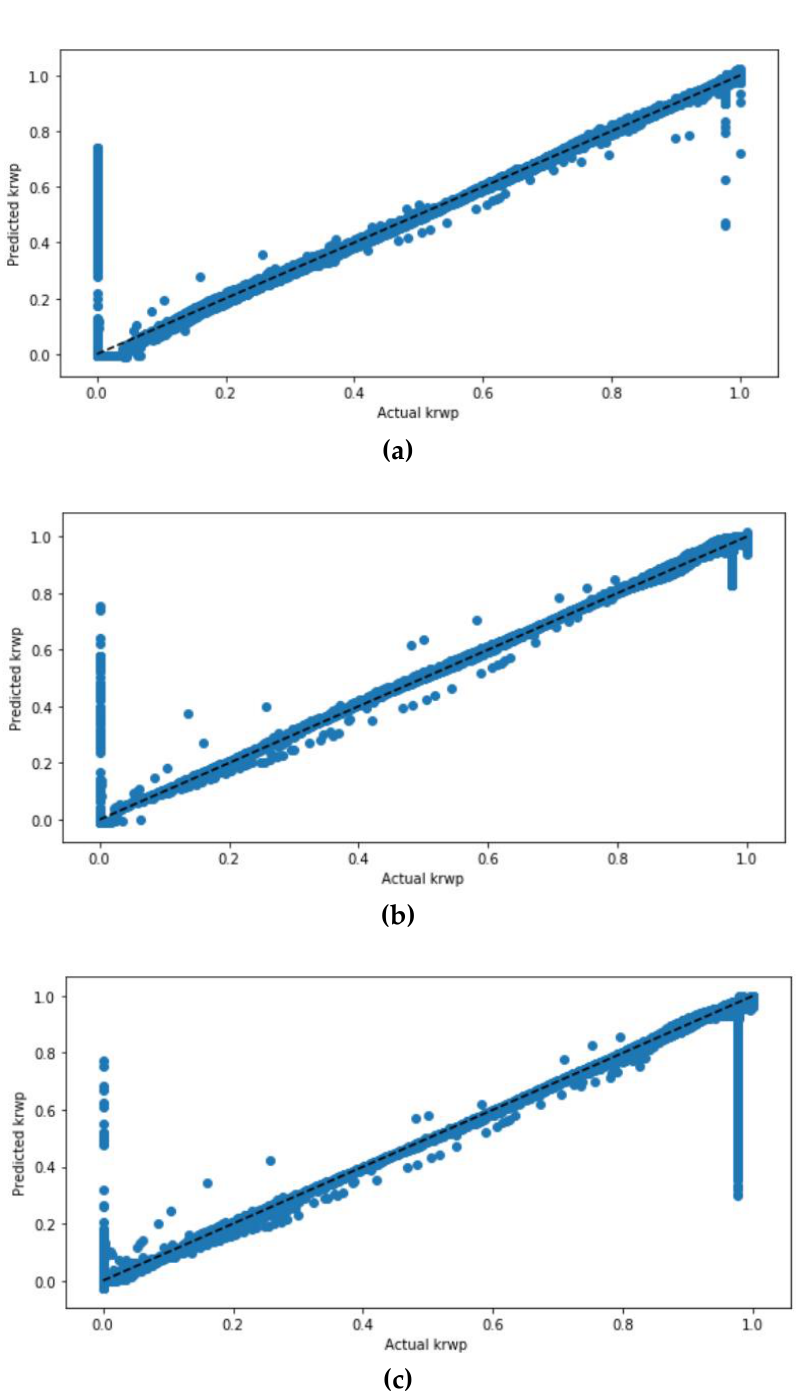
Figure 15. ANN predictions with different activation functions ( a ) “ReLu” activation function, ( b ) “sigmoid” activation function, and ( c ) “tan h ” activation function, for the target k rwp . The dashed line represents a full coinciding between actual and predicted